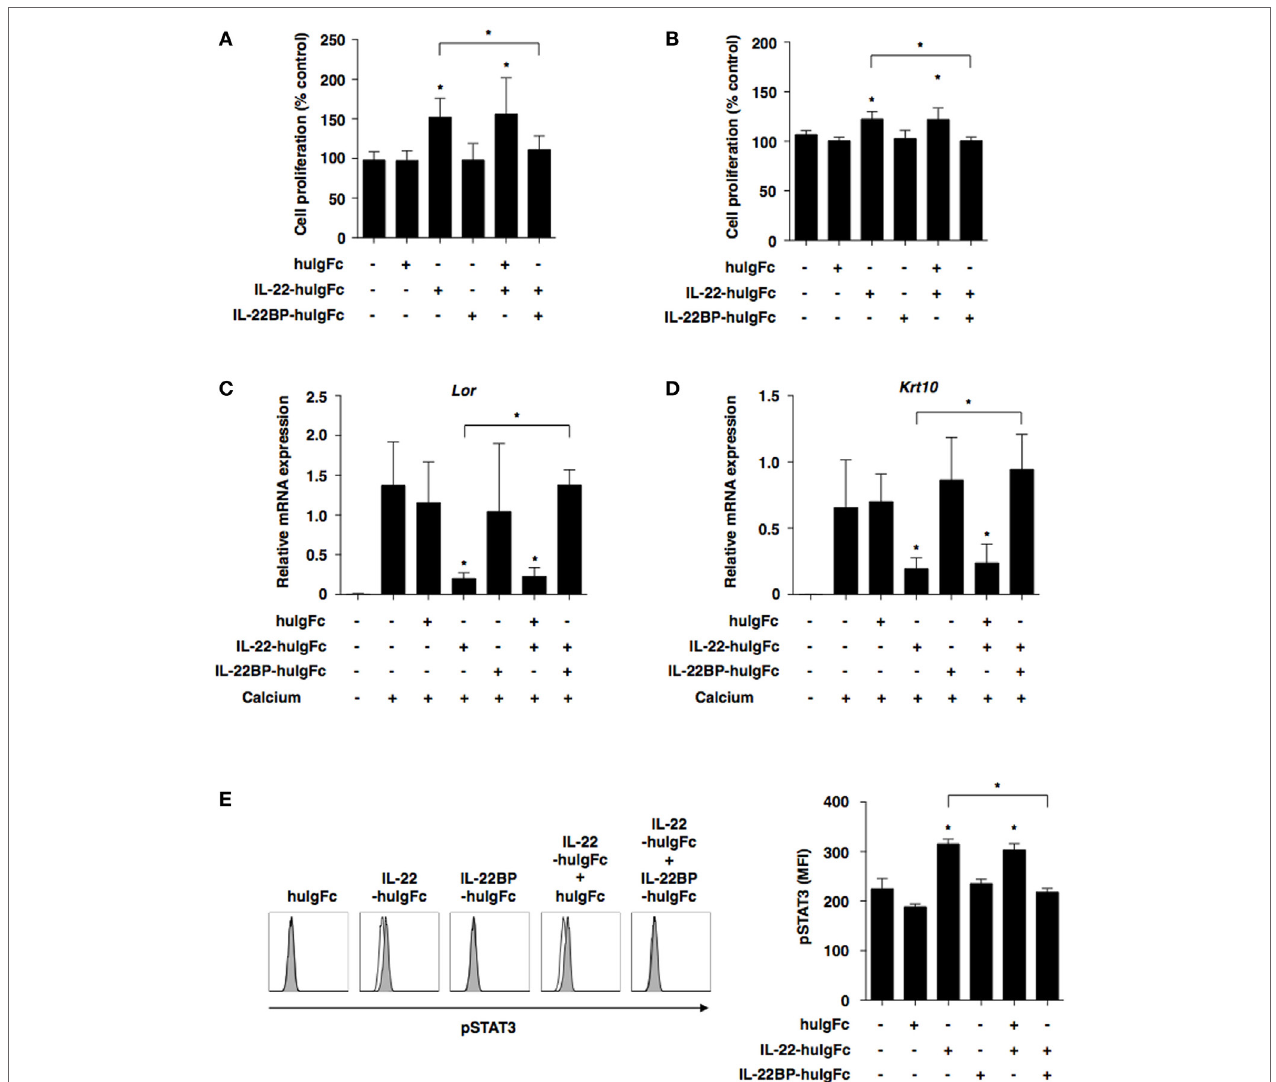
FigUre 4 | IL-22 binding protein (IL-22BP) suppresses the interleukin (IL)-22-mediated functional alternation of keratinocytes. (a–D) Keratinocytes were cultured with or without Fc fragment of human immunoglobulin (huIgFc), IL-22-huIgFc, and/or IL-22BP-huIgFc for 3 days. (a,B) Proliferative responses of keratinocytes in the absence (a) or presence (B) of extracellular calcium, with data expressed as percentage of untreated control (medium alone). Data are the mean ± SD from three individual samples in a single experiment. * P < 0.01 compared with untreated control or among groups. (c,D) Transcriptional expression of Lor (c) and Krt10 (D) in keratinocytes in the presence of extracellular calcium was analyzed by quantitative reverse transcription polymerase chain reaction at 3 days, and expression was normalized to the Actb transcript. Data are the mean ± SD from three individual samples in a single experiment. * P < 0.01 compared with untreated control (extracellular calcium) or among groups. (e) Keratinocytes were cultured with or without huIgFc, IL-22-huIgFc, and/or IL-22BP-huIgFc in the absence of extracellular calcium for 30 min, and the expression of phosphorylated STAT3 (pSTAT3) in nucleus was analyzed by flow cytometry. Data are presented as a histogram (left panel). Data are the mean fluorescence intensity (MFI) ± SD from three individual samples in a single experiment (right panel). * P < 0.01 compared with untreated control or among groups. All data are representative of at least three independent